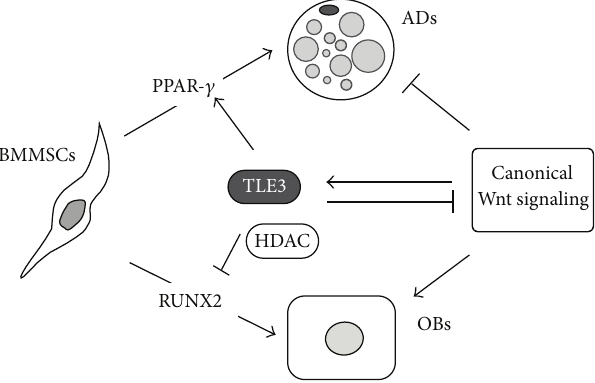
Figure 2: Model for the role of TLE3 in the bone marrow microen- vironment. TLE3 directly induces adipogenesis and suppresses osteoblastogenesis of BMMSCs by acting on PPAR- 𝛾 and RUNX2, respectively. TLE3 also indirectly induces adipogenesis and sup- presses osteoblastogenesis by repressing canonical Wnt signalling, which is capable of inducing osteoblastogenesis and inhibiting adipogenesis. In addition, canonical Wnt signalling induces TLE3 expression, suggesting that the induction of TLE3 by Wnt signalling may be part of a negative feedback loop during osteoblastogenesis and/or a positive feedback loop during adipogenesis in the adult bone marrow microenvironment. BMMSCs: bone marrow mes- enchymal stem cells; OBs: osteoblasts; ADs: